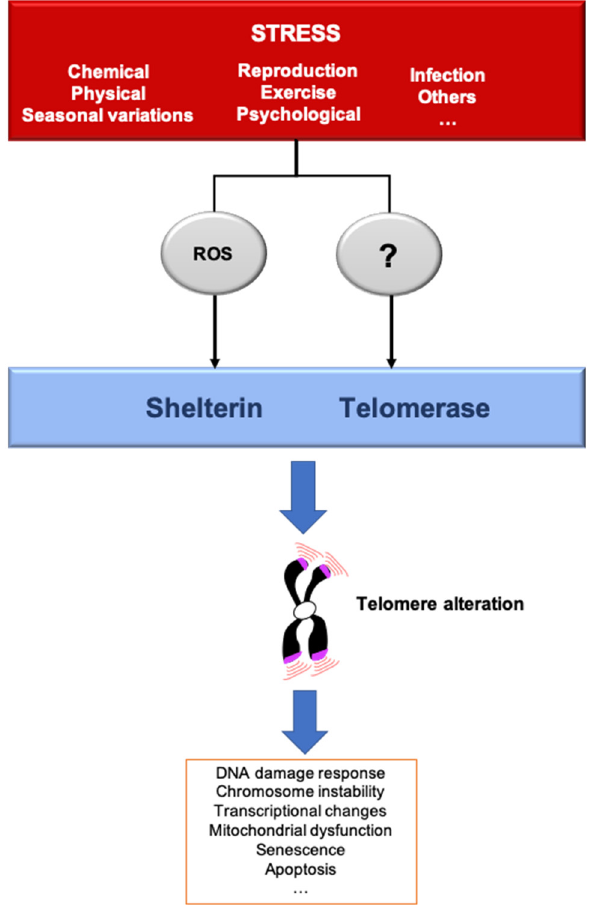
Figure 2. Stressors affect telomere homeostasis. Several stresses such as changes in pH or tempera- ture, exercise, irradiation, pathogens infection, reproduction/breeding efforts, exposure to chemicals or psychological pressure, among others, can affect telomere integrity. The most described mechanisms induced by several of these stressors include telomerase inhibition and an increase of ROS, that preferentially oxidizes the telomeric DNA, a process that we dubbed teloxidation [43]. Upon challenge, telomeric alterations induce the DNA damage response activation (DDR), senescence, transcriptional changes and mitochondrial dysfunction.